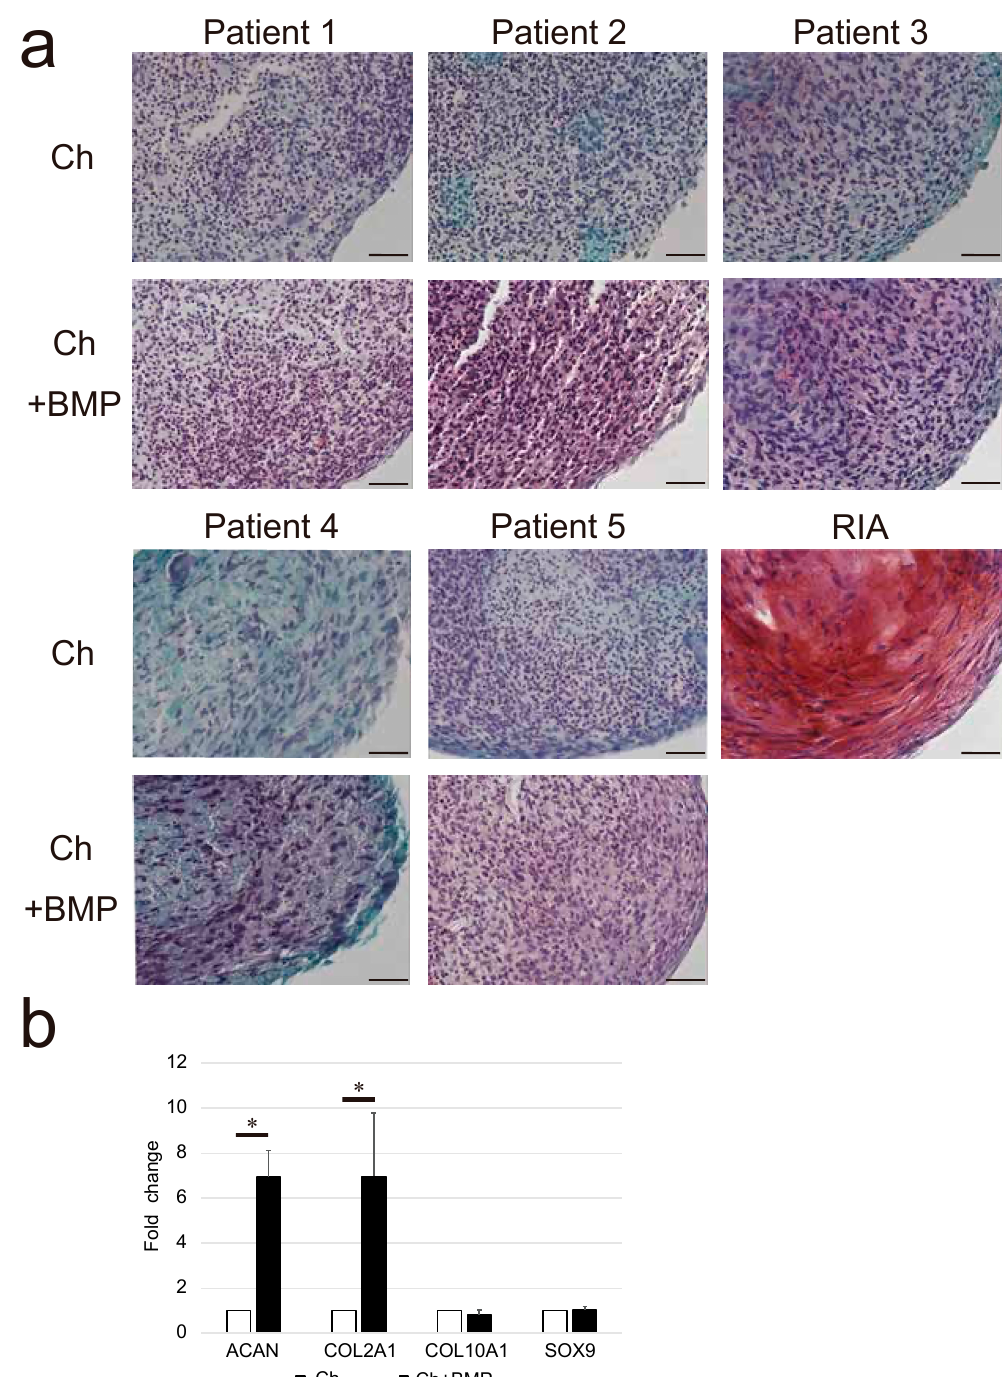
Figure 6. Analysis of the chondrogenic differentiation capability of non-hypertrophic nonunion cells (NHNCs). ( a ) Histological analysis of the chondrogenic capability of NHNCs and cells derived from a reamer-irrigator-aspirator (RIA, positive control) stained using Safranin-O after 21 days of incubation in chondrogenic medium (Ch) and Ch with E-BMP-2 (Ch + BMP). In Ch + BMP, high levels of glycosaminoglycan were deposited and observed as red staining in the extracellular matrix. Scale bars = 50 µ m. ( b ) Real-time reverse transcription-polymerase chain reaction (RT-PCR) for aggrecan ( ACAN ), collagen type II ( COL2A1 ), collagen type X ( COL10A1 ), and Sry-type high-mobility group box 9 ( SOX9 ) in the total RNA extracted from NHNC pellets in Ch and Ch + BMP on day 21. NHNCs in Ch were used as control. * p < 0.01 in the indicated groups.